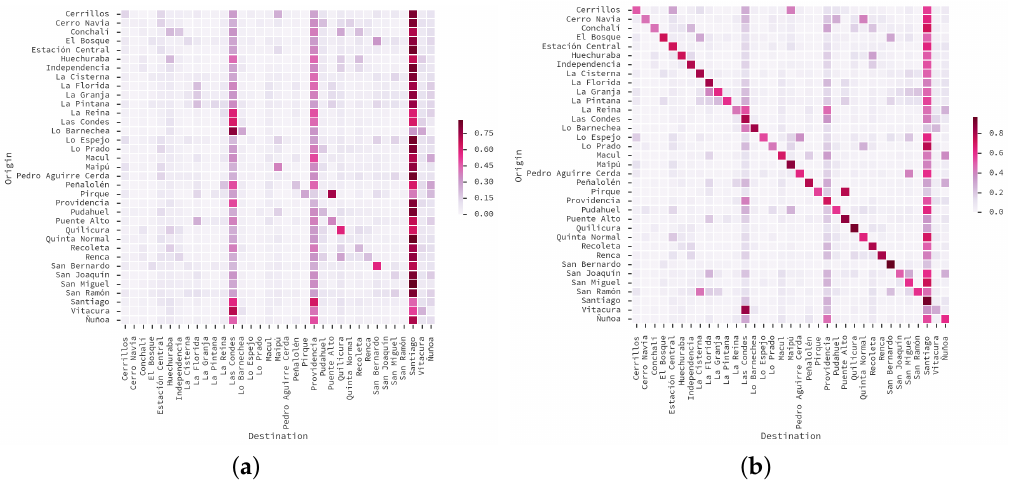
Figure 13. Comparison of OD matrices at municipal level, considering trips for work, study and shopping activities in workable days. ( a ) Matrix obtained using our method, with AVP mapping of positions; ( b ) Matrix with trips extracted from the